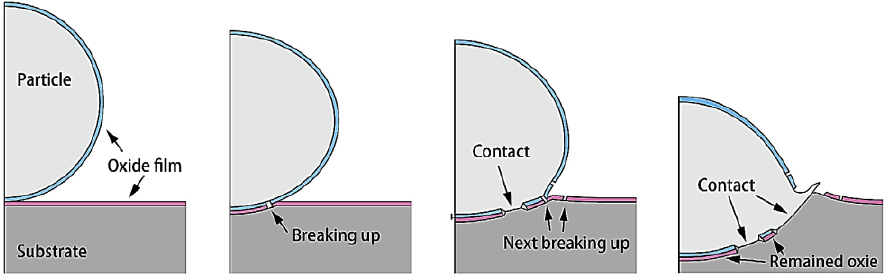
Figure 2. The breakup of the oxide surface shell upon the impact of powder particles in the CS process. Reprinted from Ichikawa et al. [51], Copyright 2018, with permission from Elsevier.